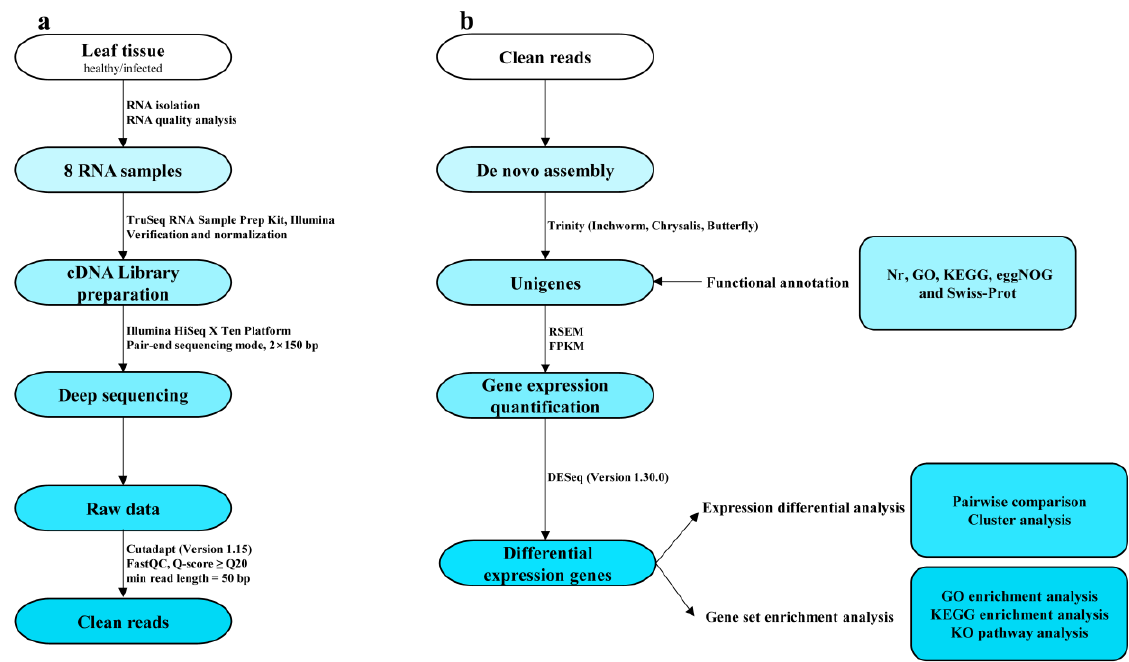
Figure 2. Overview of RNA-seq analysis workflows. ( a ) Acquisition of high-quality sequence (clean reads) from 8 normalized RNA samples. ( b ) The protocol of de novo assembly by Trinity, annotation and downstream analysis for differential expression genes (DEGs).